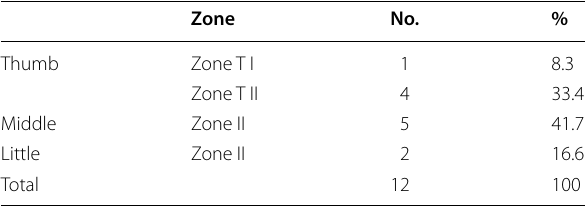
Table 3 Distribution of the finger injuries among the fingers and its exact flexor zone as depicted by MRI (affected finger and zone):